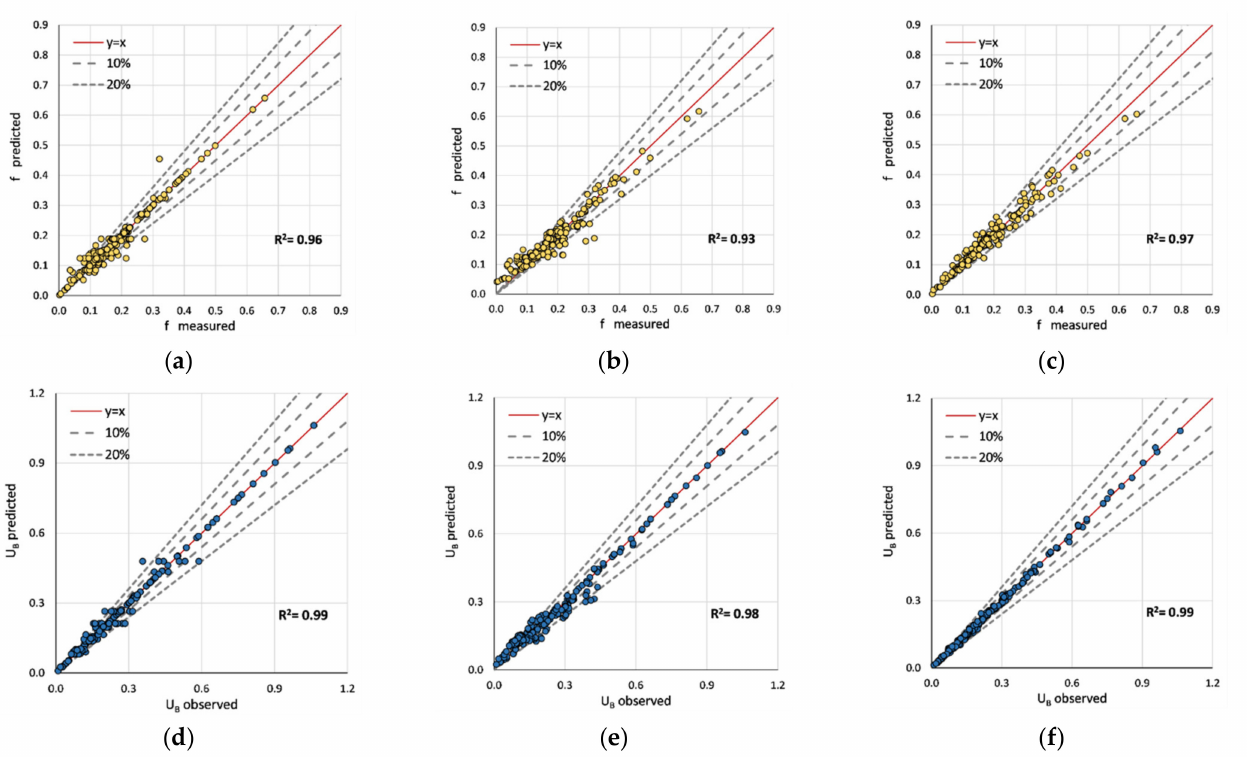
Figure 4. Comparison of training accuracies of ML models (both f S and U B ): ( a ) decision tree regressor; ( b ) extra tree regressor; ( c ) XGBoost regressor; ( d ) decision tree regressor; ( e ) extra tree regressor; ( f ) XGBoost